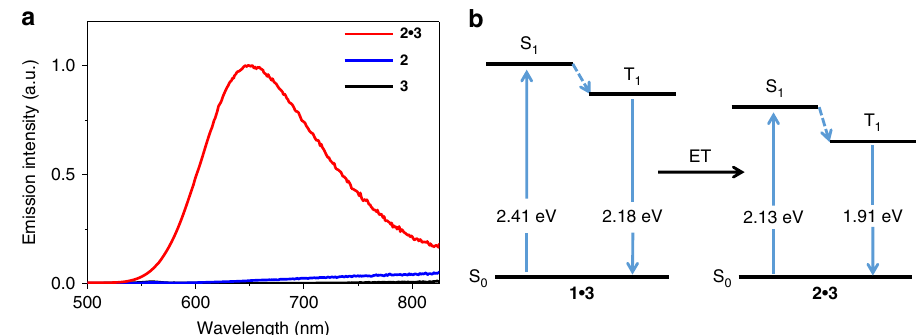
Fig. 5 Characterization of co-assembled system from 2 (cid:129) 3 . a Emission spectra of 2 , 3 , and complex 2 (cid:129) 3 [5.00 × 10 − 5 M for each compound in water/ methanol (90:10, v / v )]. b Energy diagram of complexes 1 (cid:129) 3 and 2 (cid:129) 3 . The triplet energy was determined by the emission maximum (568 and 648 nm for complexes 1 (cid:129) 3 and 2 (cid:129) 3 , respectively). The singlet energy was determined by the absorption onset on the lower energy side (515 and 580 nm for complexes 1 (cid:129) 3 and 2 (cid:129) 3